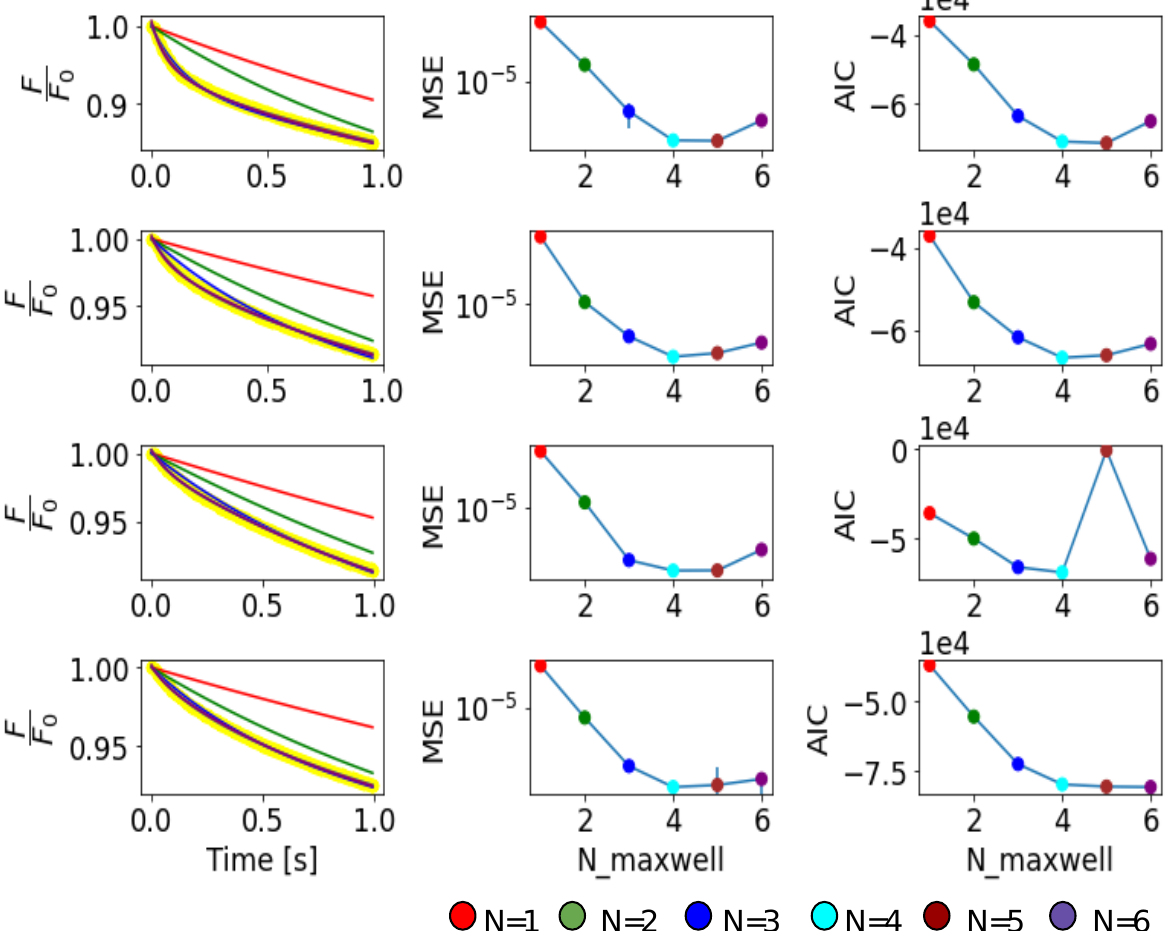
Figure A7. Example of the method of determination of best GMM fitting order for stiff PAM hydrogel samples. The left column shows the experimental data of 4 curves (yellow) together with their GMM fittings of different orders (corresponding to a different number of Maxwell elements, or arms). Each dot presented in the graphs at the center and right columns are the MSE criterion (center) and Akaike information criterion (right) for N arms in the GMM fitting, showing which order is the best.